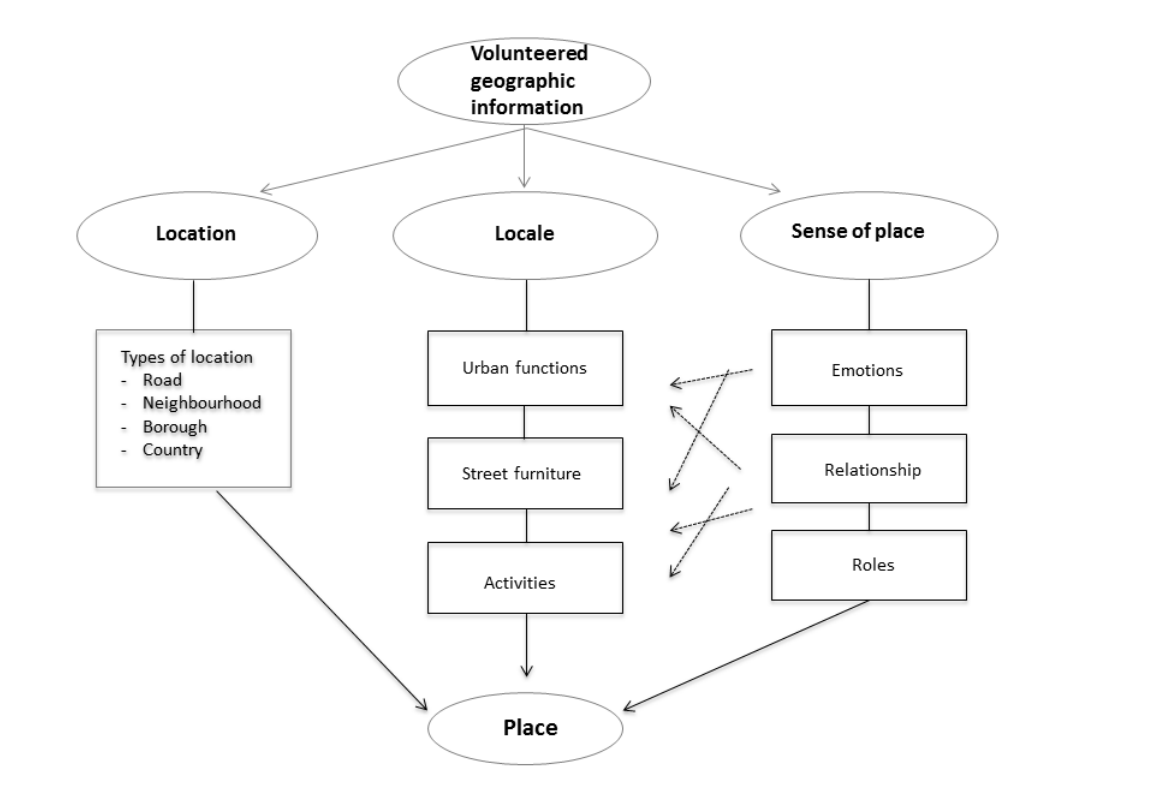
Figure 1. VGI and place: A conceptual schematic